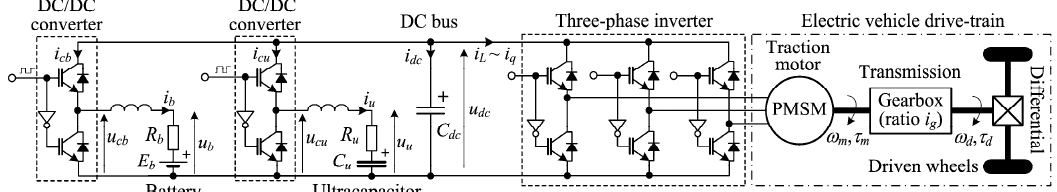
Figure 1. Considered EV power-train with parallel-connected battery and ultracapacitor ESS and vehicle traction AC electrical drive based on permanent-magnet synchronous motor (PMSM).